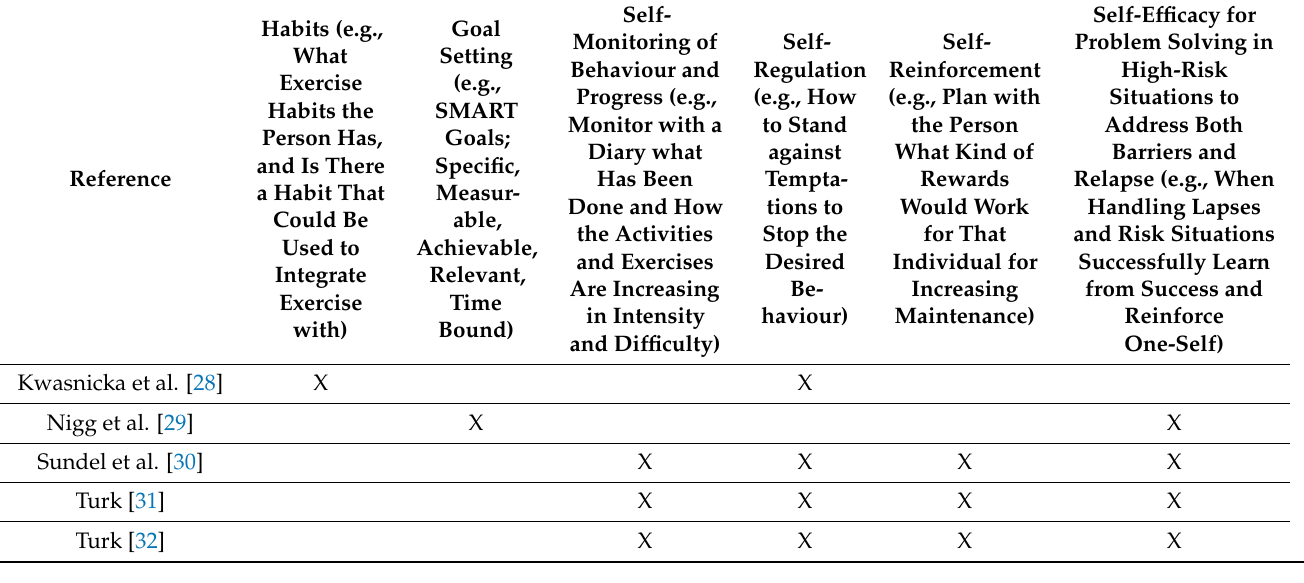
Table 8. Maintenance of behavioural change components categorized according to the behavioural wheel presented by Michie et al. [42] regarding capability, motivation and opportunity. Opportunity: Opportunity consists of behaviour prompting factors external to the